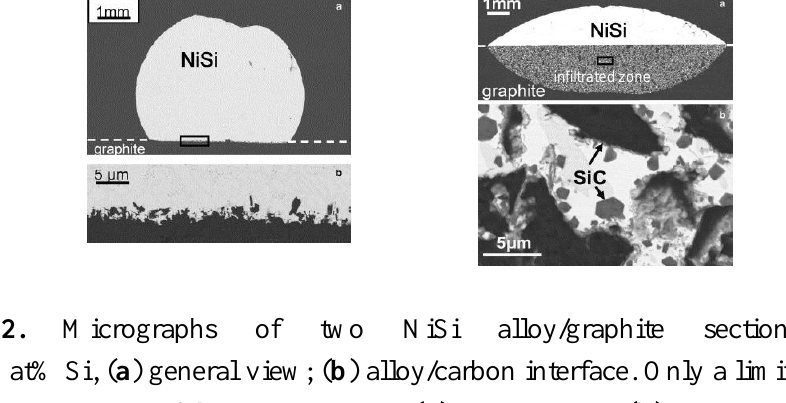
Figure 12. Micrographs of two NiSi alloy/graphite sectioned samples, Left : Ni-21 at% Si, ( a ) general view; ( b ) alloy/carbon interface. Only a limited dissolution of graphite is observed. Right : Ni-47 at% Si, ( a ) general view; ( b ) an area of the infiltrated zone [20]. T = 1270